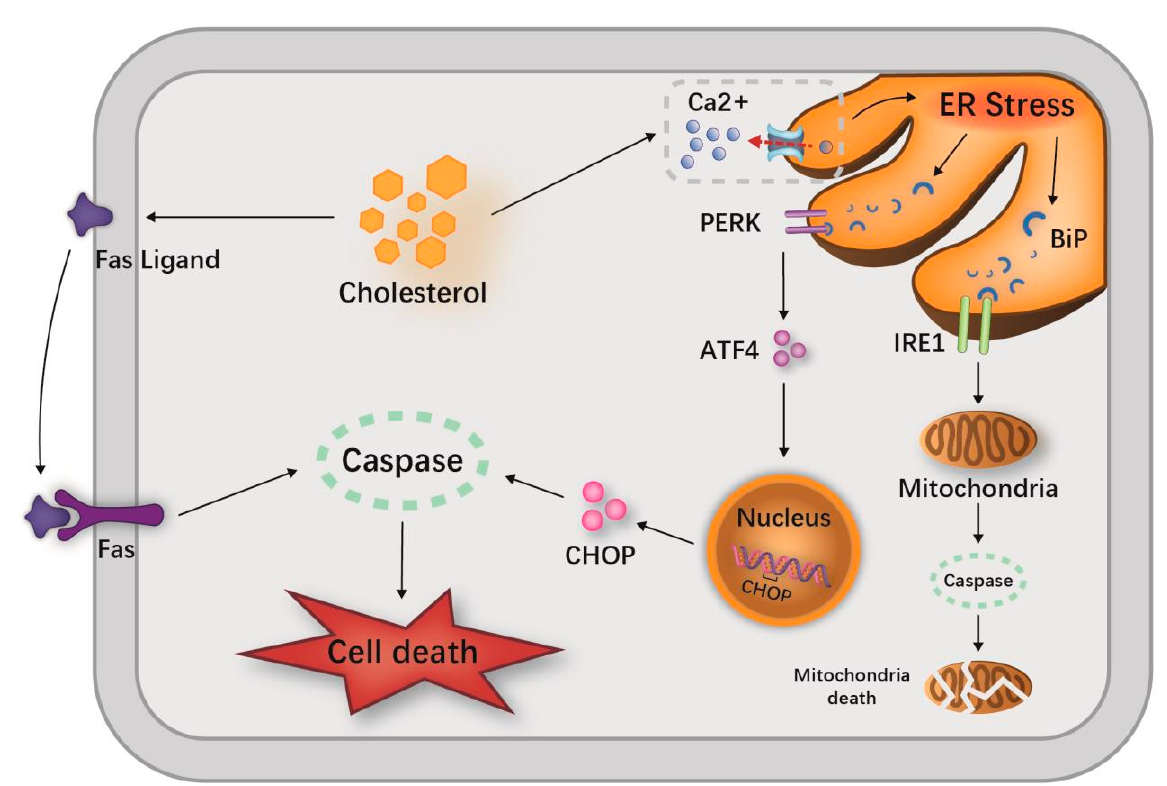
Figure 4. Several pathways of cholesterol-induced cell death. The abnormal loading of cholesterol in the ER membrane leads to the exhaustion of ER calcium stores and ER stress, initiating the UPR and ultimately apoptosis, as well as the release of the ER chaperone BiP, which activates the UPR sensors PERK and IRE1. Activated PERK mediates the translation of ATF4 and promotes the expression of CHOP. Activated IRE1 induces a mitochondria-dependent caspase cascade. ER stress also promotes caspase-12 cleavage and activation, initiating caspase activation and leading to programmed cell death. Free cholesterol can also trigger apoptosis though the Fas pathway.